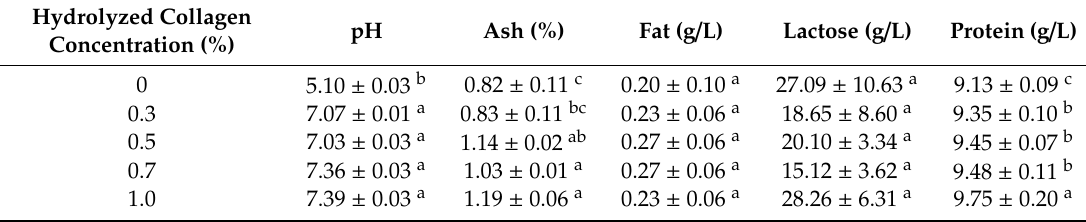
Table 1. Functional beverage physicochemical